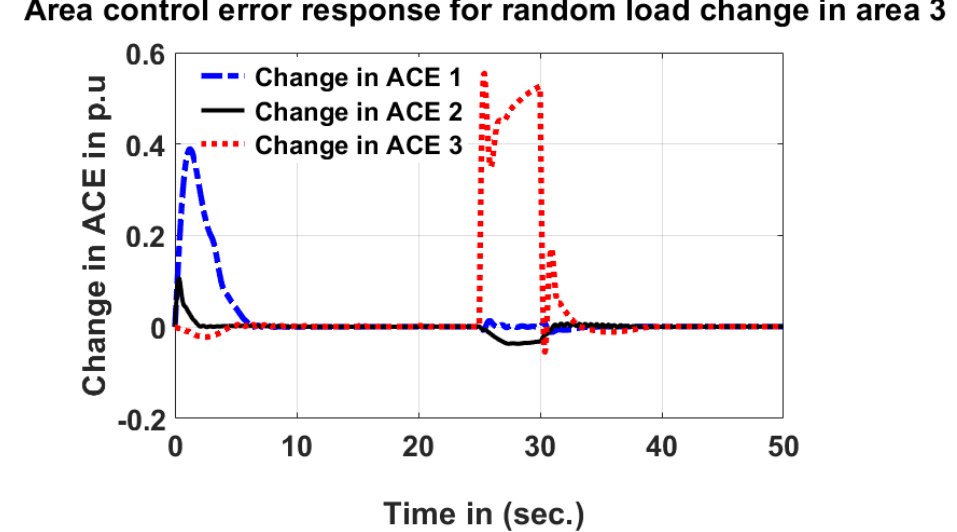
Figure 28. Change in tie-line power responses of area 1, area 2, and area 3 for random load change in area 3 only.